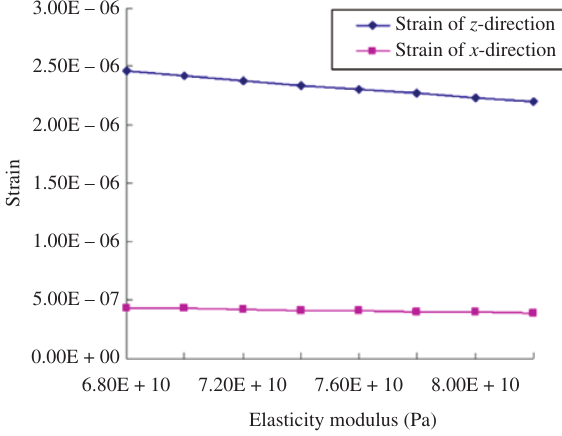
Figure 6: Relationship between piezoelectric dielectric coefficient and strain of composite